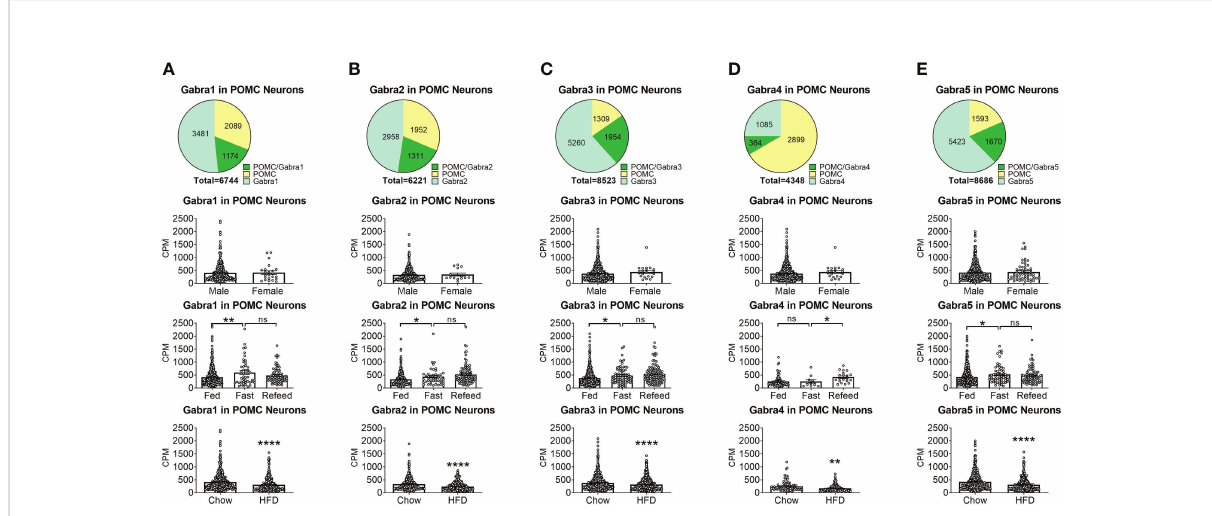
FIGURE 1 The expression of Gabra subunits of GABA A receptors in ARH POMC neurons. (A) Gabra1, (B) Gabra2, (C) Gabra3, (D) Gabra4, (E) Gabra5. On the fi rst row are pie graphs showing the percentage of three neuron populations: POMC+/GABA receptor subunit+ or both, POMC+/GABA receptor subunit- and POMC-/GABA receptor subunit+, in all the neurons that express either POMC or each stated GABA receptor subunit or both. The bar graphs showed the expression of each GABA receptor subunit in POMC neurons between male vs female mice fed on chow diet (the second row), among fed vs fasting vs refeeding conditions from male mice fed on chow diet (the third row), and from male mice fed on chow vs HFD (the fourth row). ns, not signi fi cant. *, **, **** P < 0.05, 0.01 or 0.0001 in unpaired